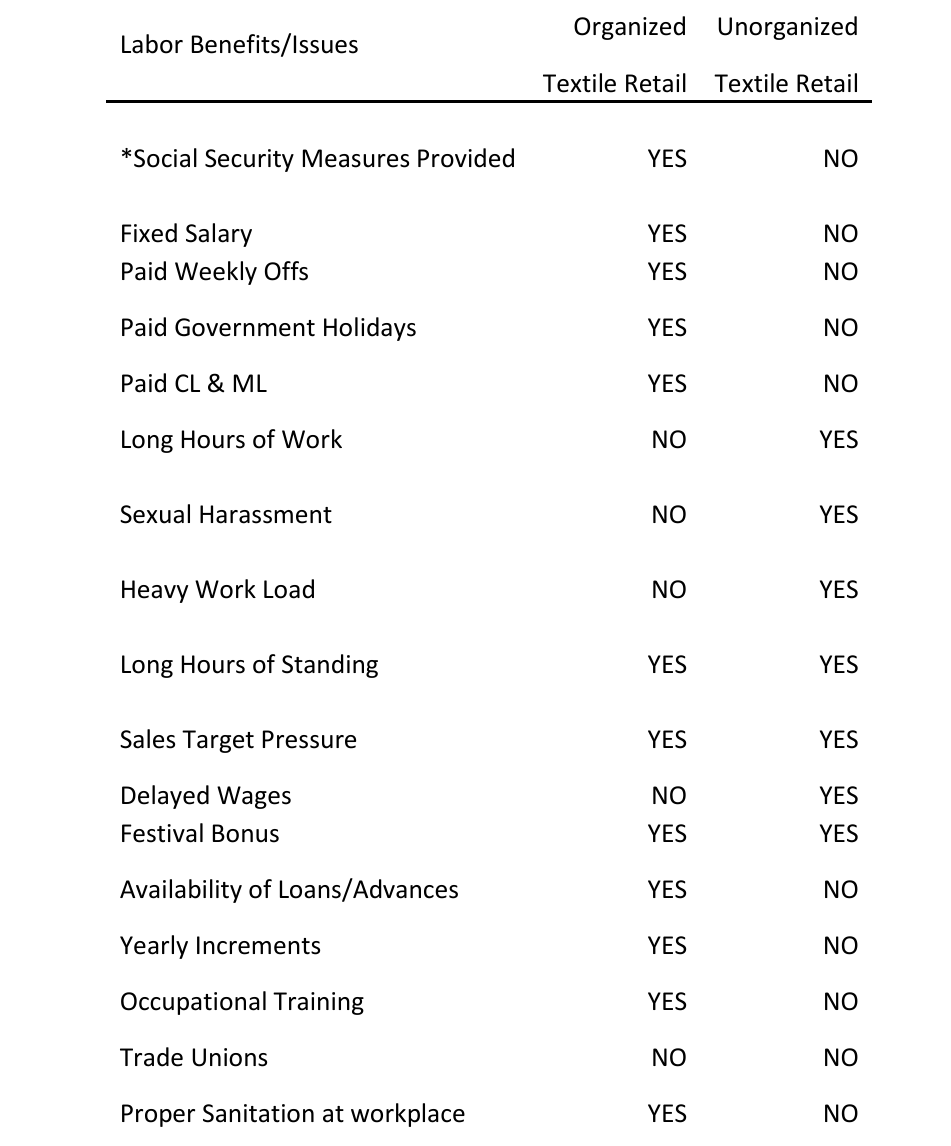
Table 1: Major Difference between Organized and Unorganized Textile Retail Stores Labor